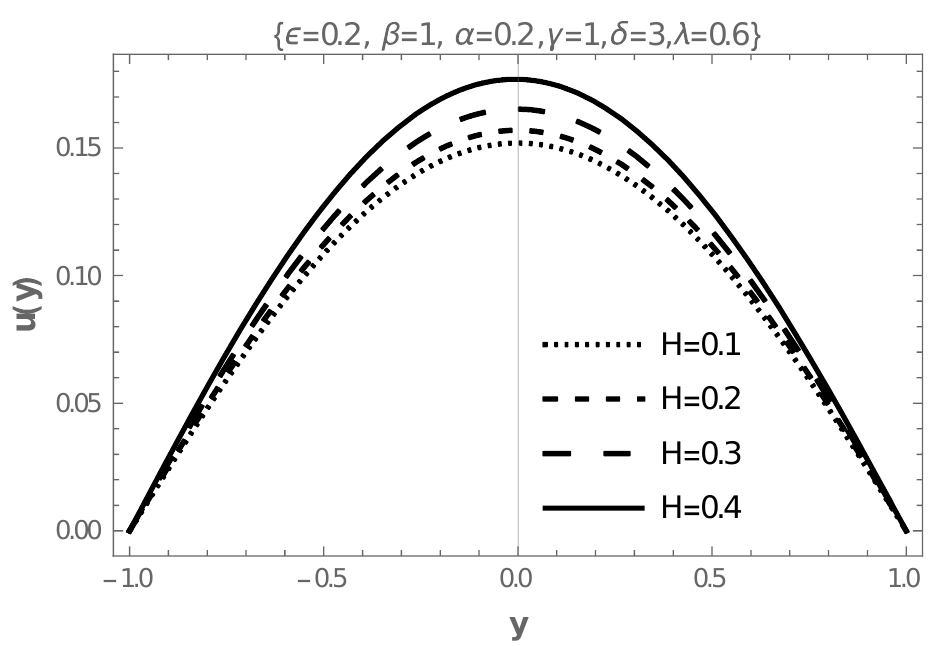
Figure 5. Temperature distribution with couple stress inverse parameter (  ).